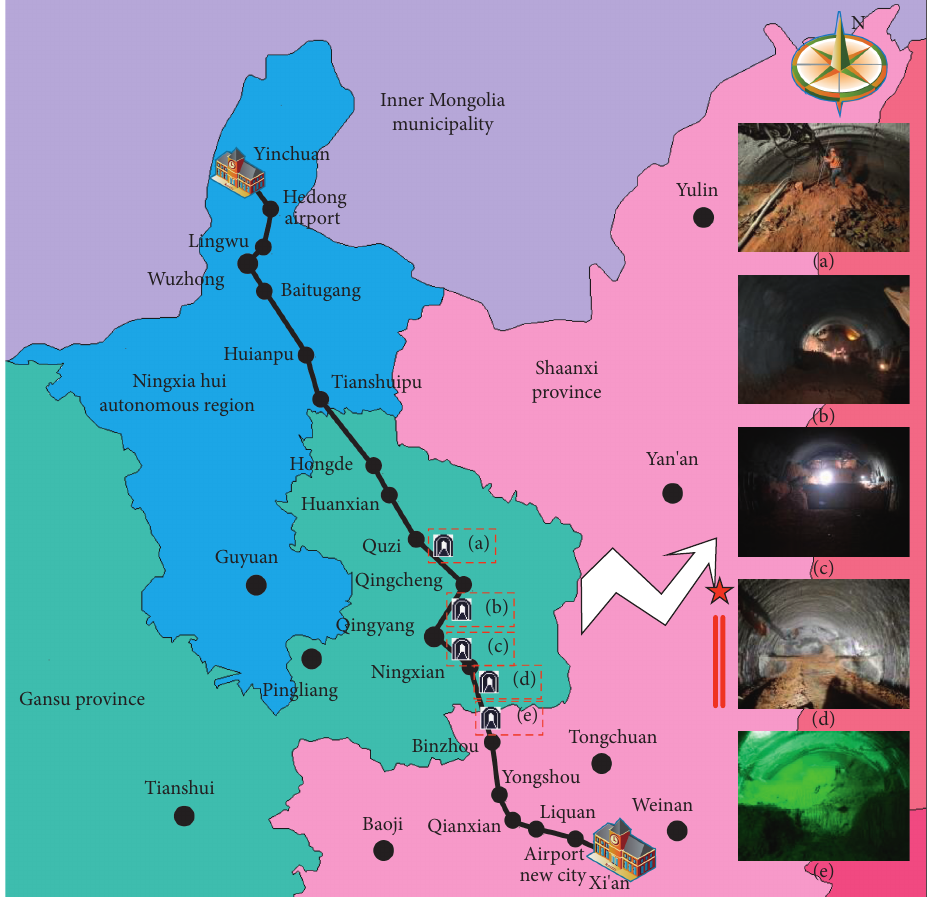
Figure 1: Yinchuan-Xi’an high-speed rail route map. (a) Earth-rock tunnel. (b) Red clay tunnel. (c) Soft plastic loess tunnel. (d) Weak expansive paleosol tunnel. (e) Collapsible loess tunnel. Table 1: Initial support design